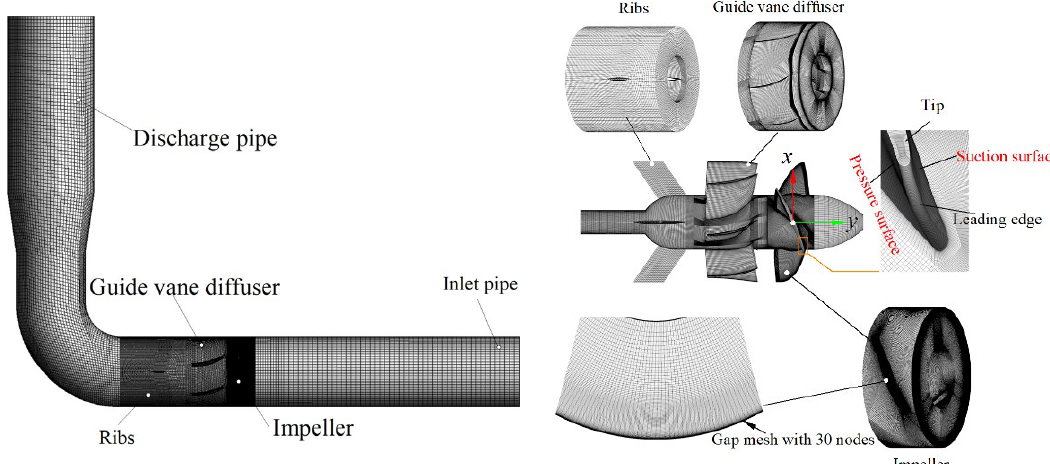
Figure 3. Computational grid of main components.